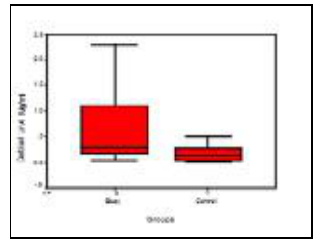
Figure 8: Cortisol of the study and control groups